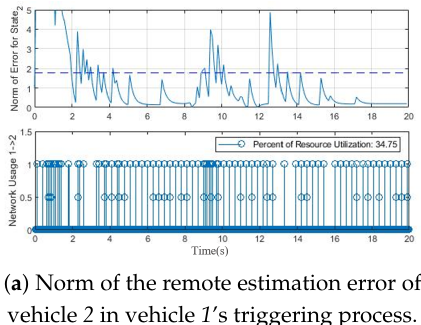
Figure 7. Remote estimation error in